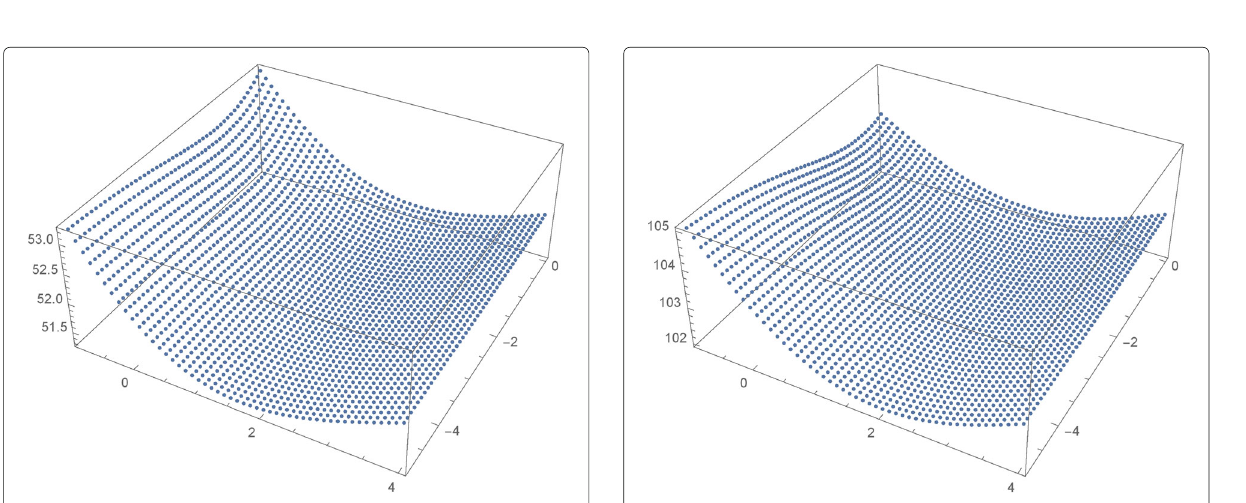
Fig. 17 Expectation value of the procurement cost E [ C